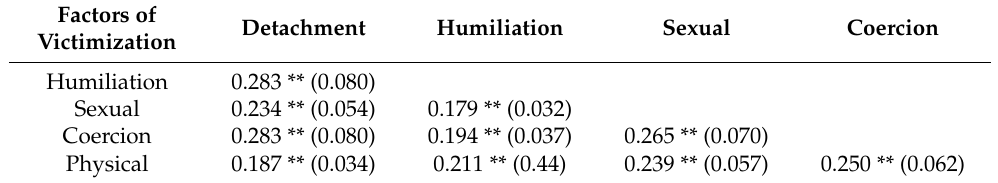
Table 2. Analysis of correlations and effect size. Factors of Detachment Humiliation Sexual Victimization